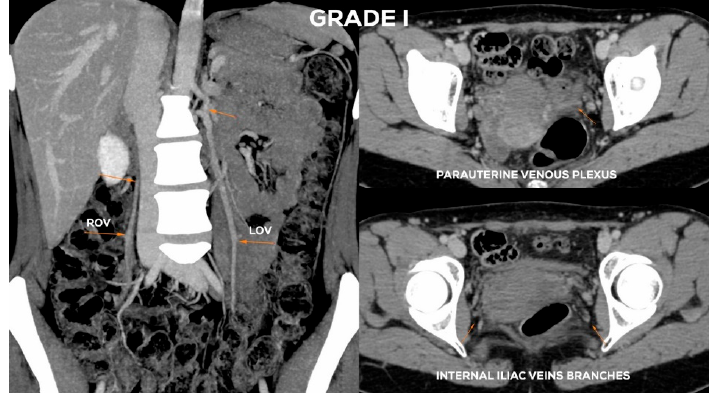
Figure 9. Typical findings in patient with Grade I ovarian veins insufficiency seen on a CTV images in coronal and axial planes.